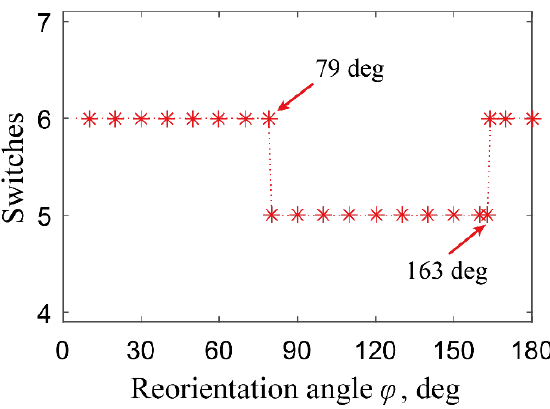
Figure 9. The total numbers of switches from 10 to 180 deg for Case